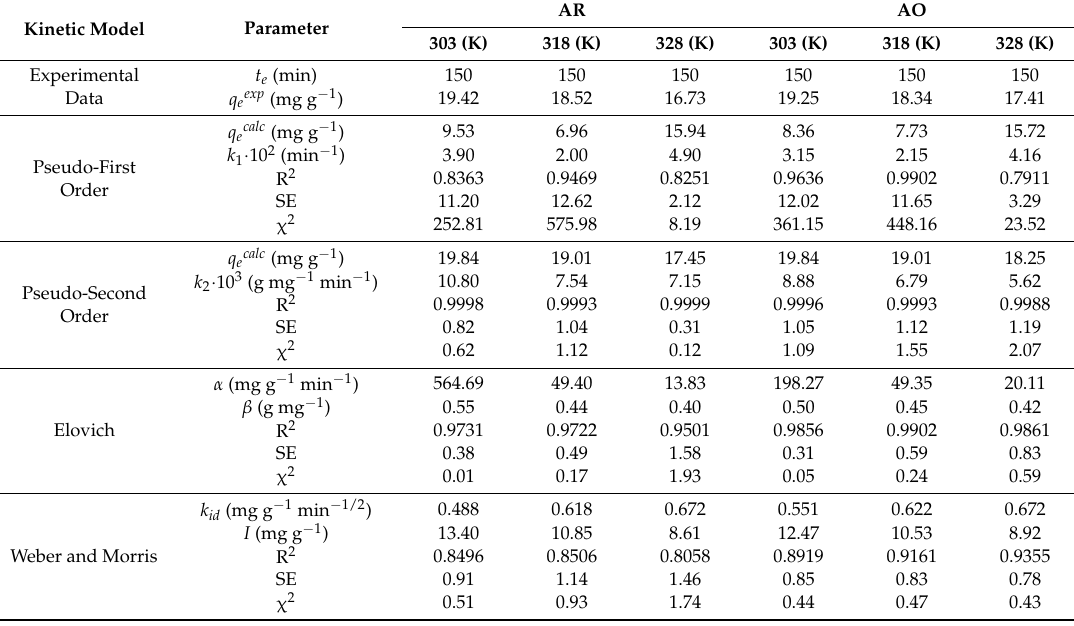
Table 4. Comparison of the kinetic models.